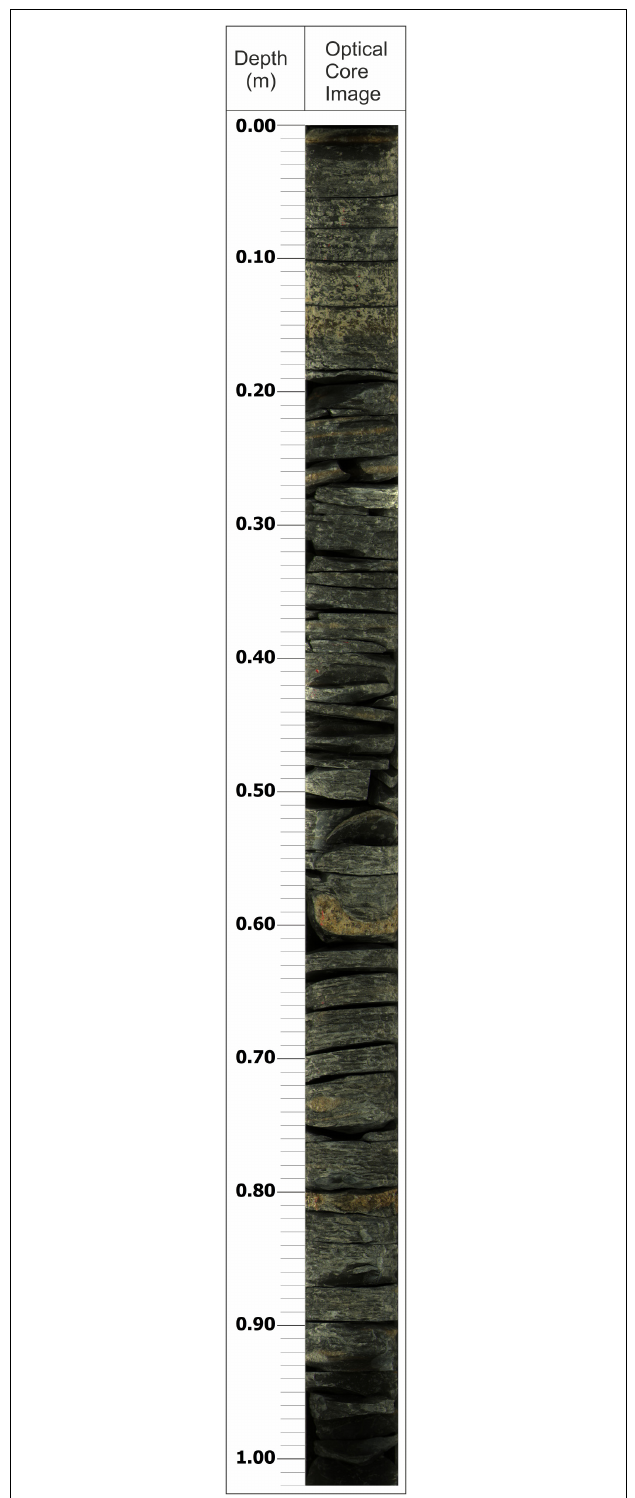
FIGURE 4 | Optical line scan image of a 1.02 m section of core from the Melbourne 1 borehole (985.66 m – 986.68 m) showing a large number of low angle fractures along bedding planes. Due to the condition of the core there was not sufficient coherent material to undertake UCS tests.